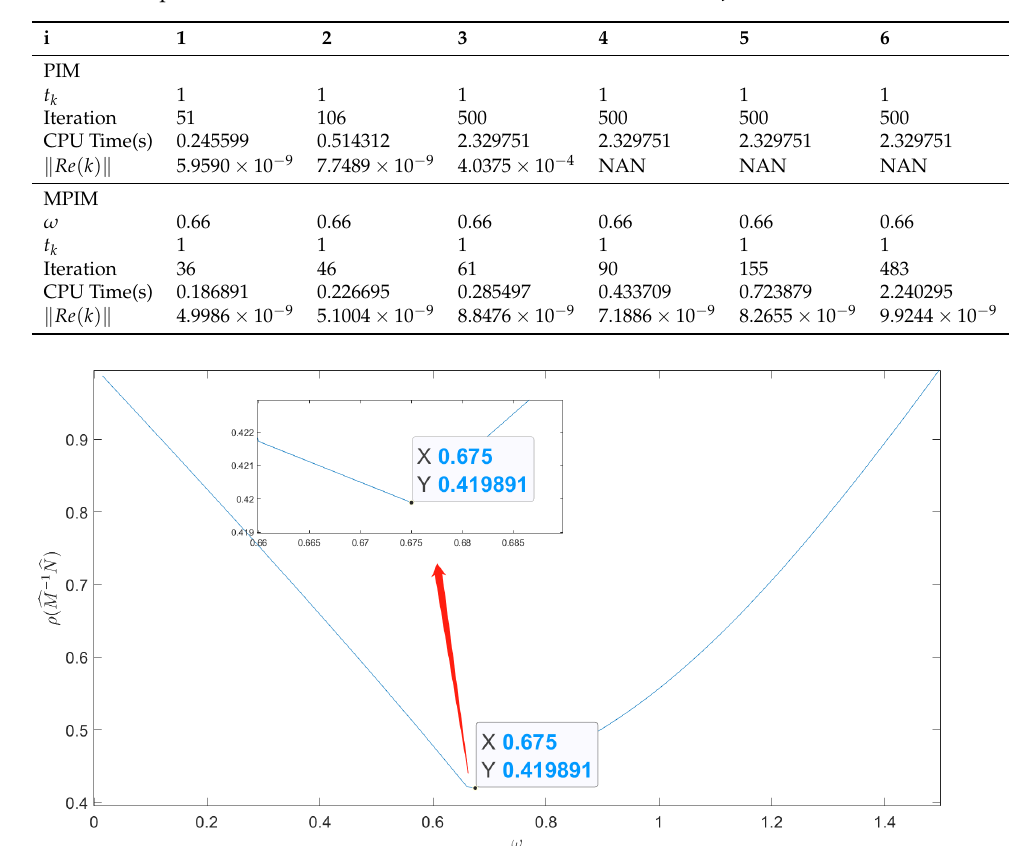
Table 2. Comparision of the iteration number and the CPU time for M i , i = 3,4.